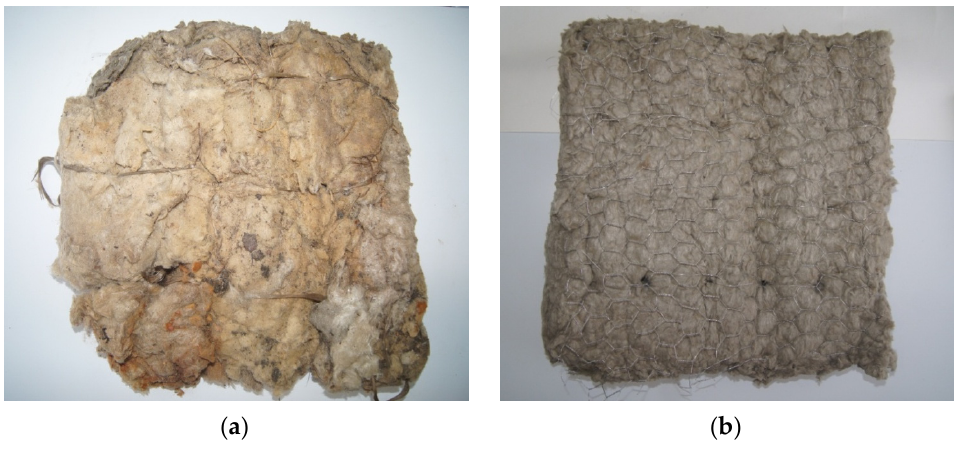
Figure 3. The studied samples of basalt fibre: ( a ) used; ( b )